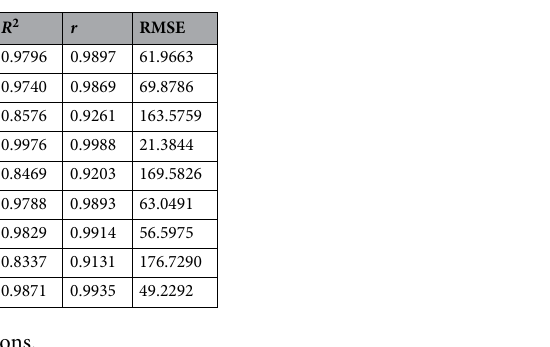
Table 2. Errors of different transfer